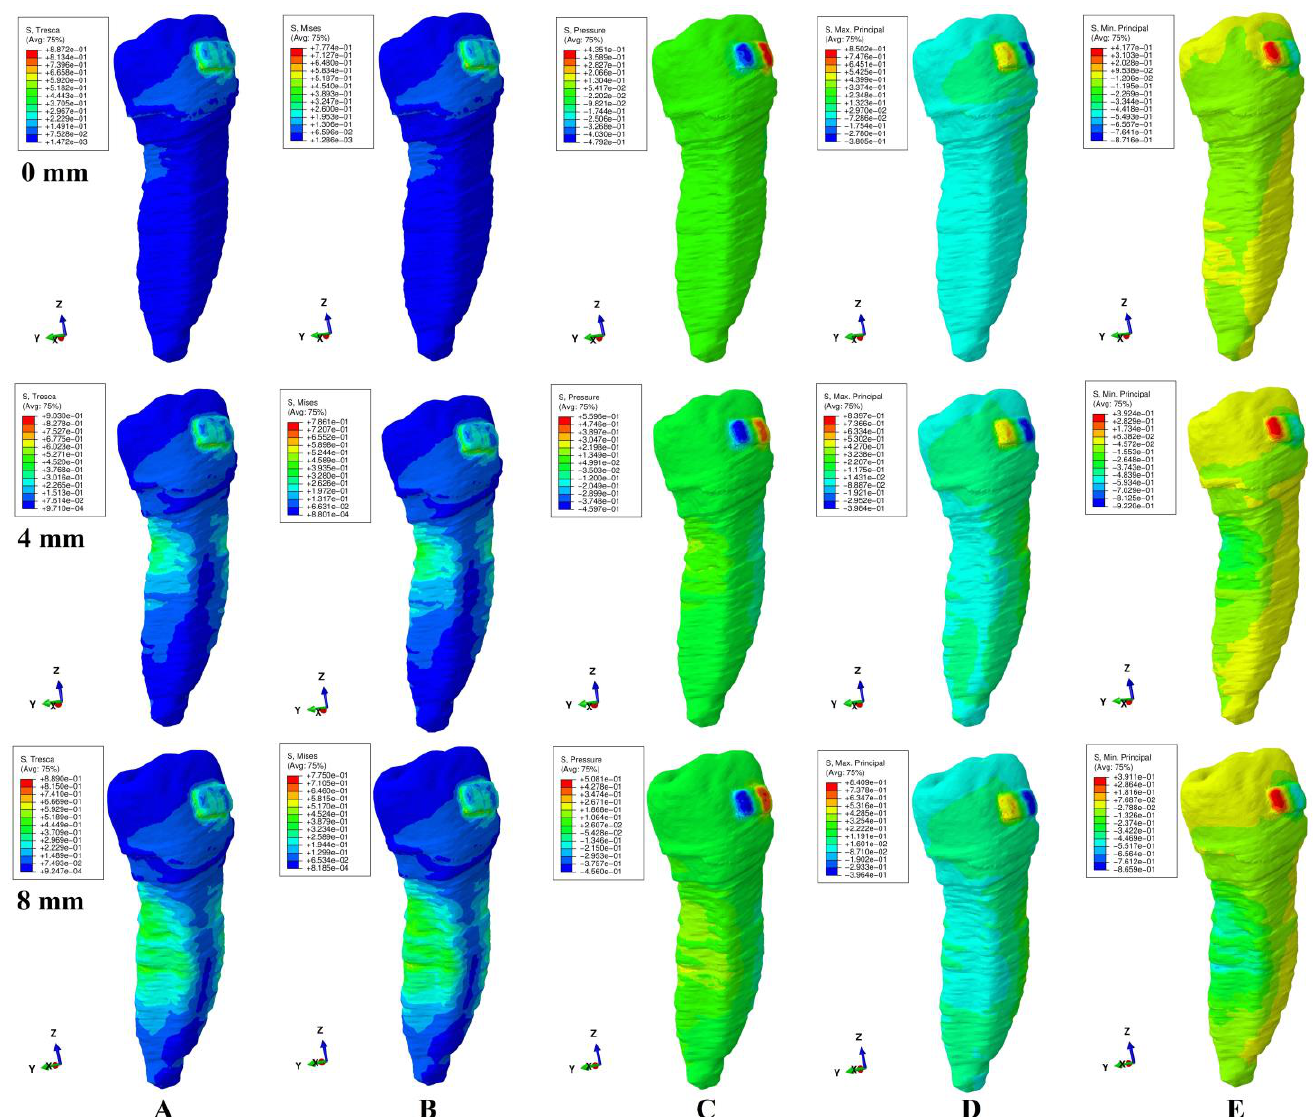
Figure 5. Comparative stress display of the five failure criteria in intact, 4 mm and 8 mm periodontal breakdown for the rotation movement under 0.5 N of load: ( A ) Tresca; ( B ) Von Mises; ( C ) Pressure; ( D ) S1; ( E ) S3.